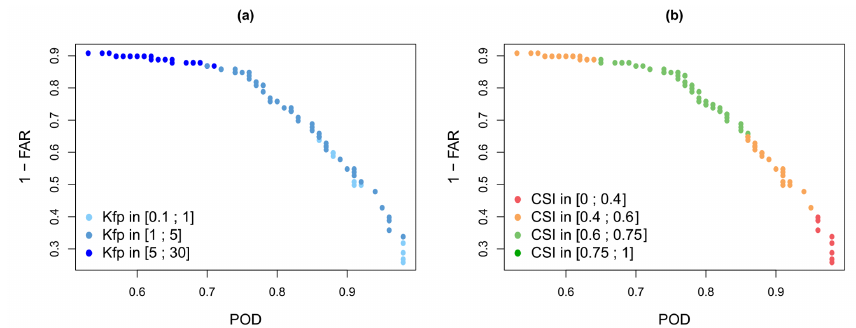
Figure 10. Pareto diagram for two forecast scores, POD and FAR. 1-FAR is used so that each criterion evolves in the same way, (a) distribu- tion of K fp values and (b) distribution of CSI values according to POD and 1-FAR.